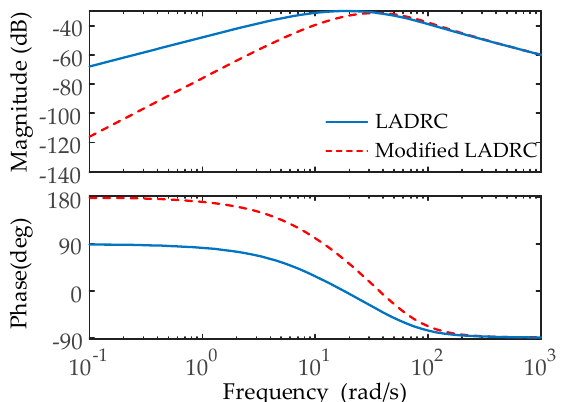
Figure 9. Comparison of disturbance rejection performance between conventional LADRC and modified one.